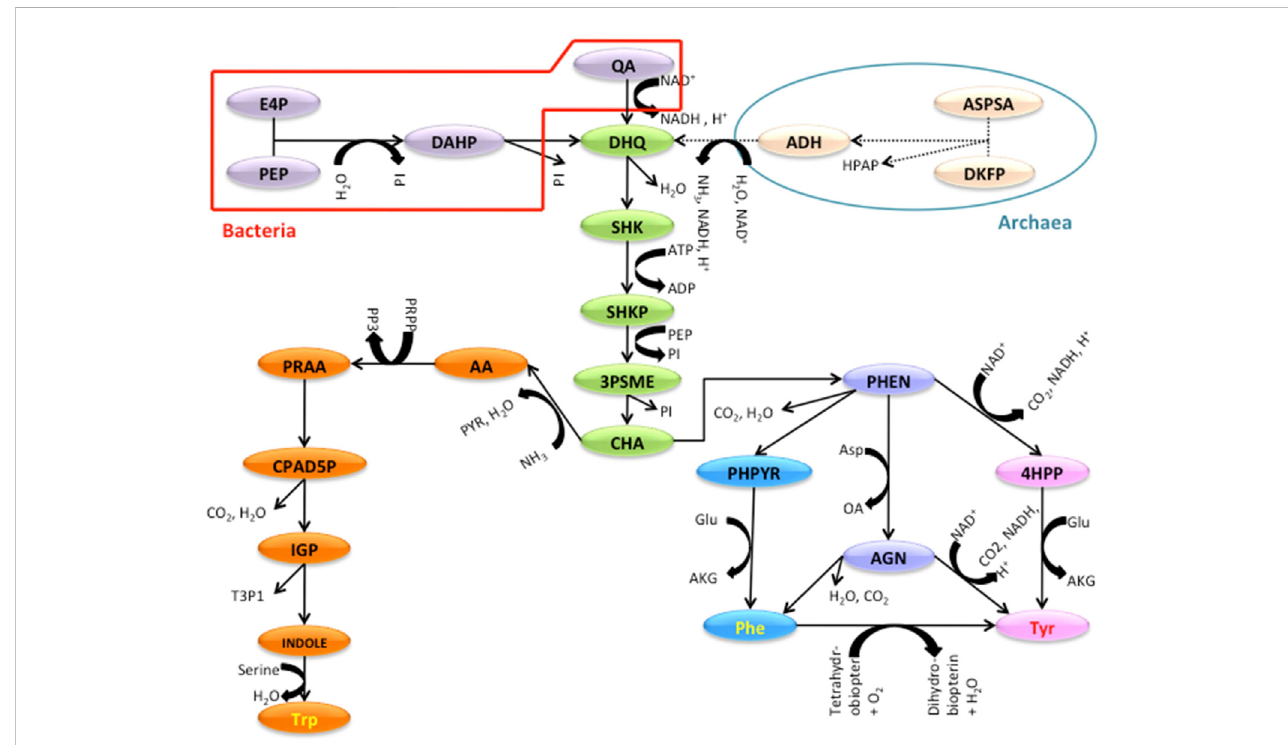
FIGURE 1 The TTP Pathway studied with the sections indicated. Red and blue shapes are speci fi c to Bacterial and Archaeal TTP pathway. The Green substrates are part of the Shikimate section. Orange is for Tryptophan and Blue and Pink are for the Phenylalanine and Tyrosine parts. INPUT SECTION: In bacteria; E4P (D-Erythrose-4-phosphate),PEP(Phosphoenolpyruvate),DAHP(2-Dehydro-3-deoxy-D-arabino-heptonate7-phosphate),QA(Quinate),DKFP(6-deoxy-5- ketofructose-1-phosphate). In archaea; ASPSA (Aspartate semi aldehyde). SHIKIMATE SECTION: DHQ (3-dehydroquinate), SHK (Shikimate), SHKP (Shikimate 3-phosphate), 3PSME (5-O-(1-Carboxyvinyl)-3-phosphoshikimate), CHA (Chorismate). TRYPTOPHAN SECTION: AA (Anthranilate), PRAA (N-(5- Phospho-D-ribosyl)anthranilate), CPAD5P (1-(2-Carboxyphenylamino)-1-deoxy-D-ribulose 5-phosphate), IGP (Indoleglycerol phosphate), INDOLE, Trp (Tryptophan). PHENYLALANINE AND TYROSINE SECTION: PHEN (Prephenate), PHPYR (Phenylpyruvate), 4HPP (4-Hydroxyphenylpyruvate), AGN (L-Arogenate), Phe (Phenylalanine), Tyr